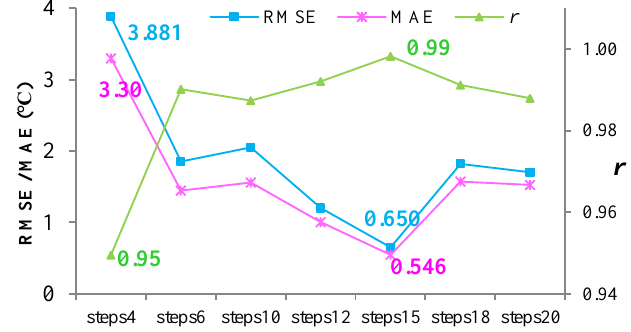
Figure 8. Prediction accuracy for 12 months under different steps.